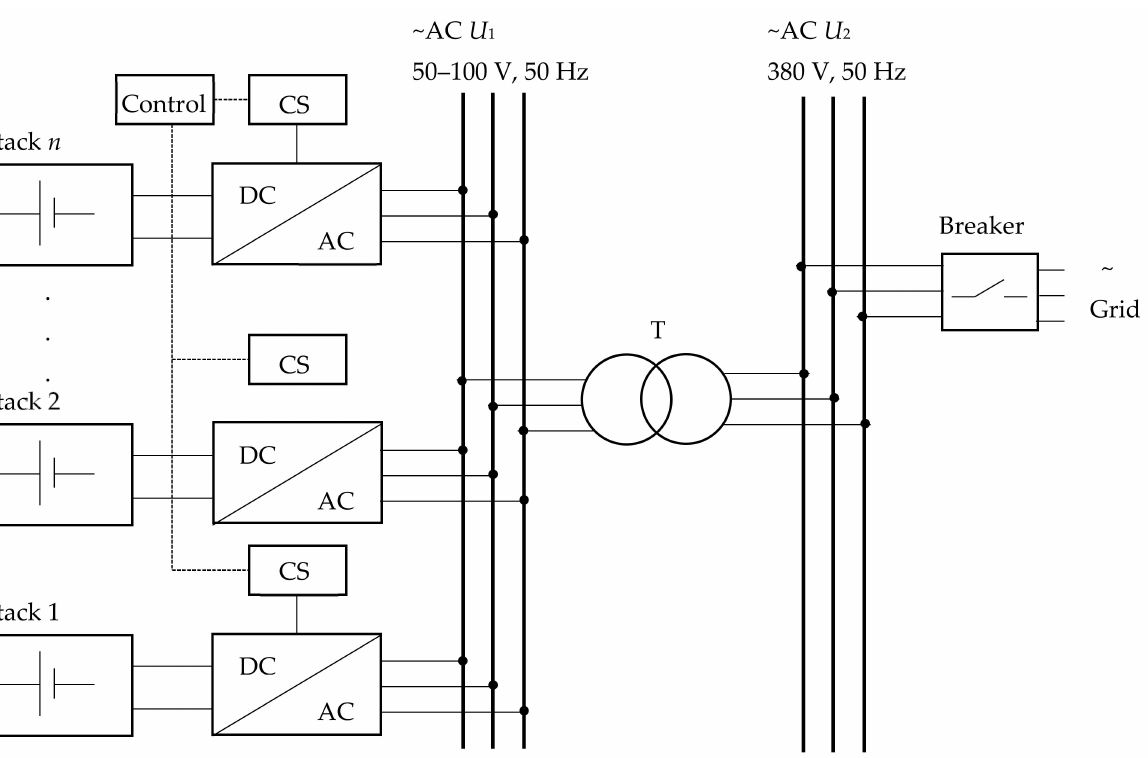
Figure 9. Functional diagram of circuit for VRB parallel operation.